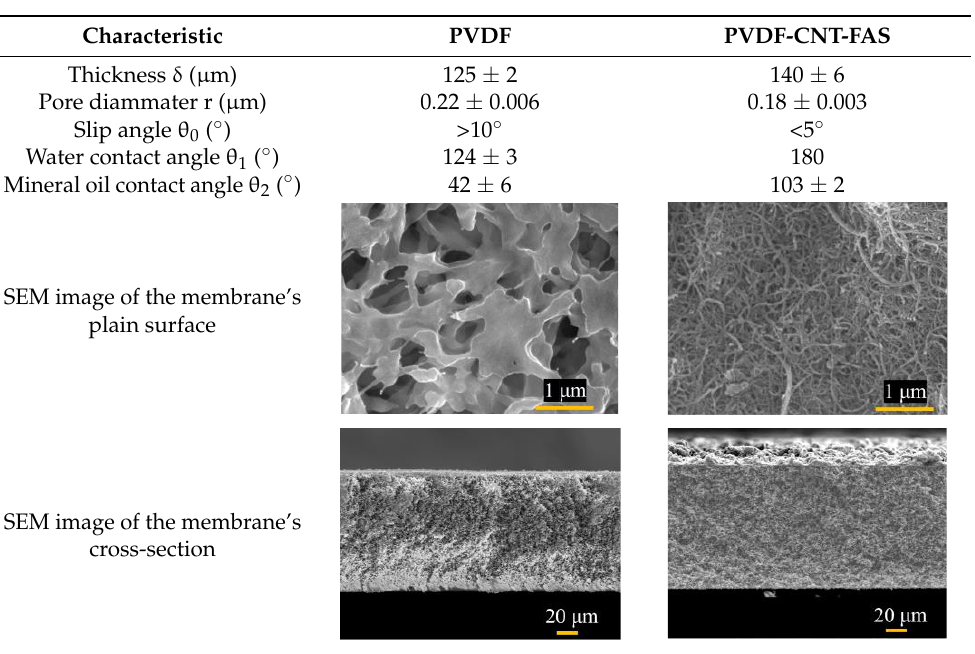
Table 2. Basic characteristics of the PVDF and PVDF-CNT-FAS membranes.